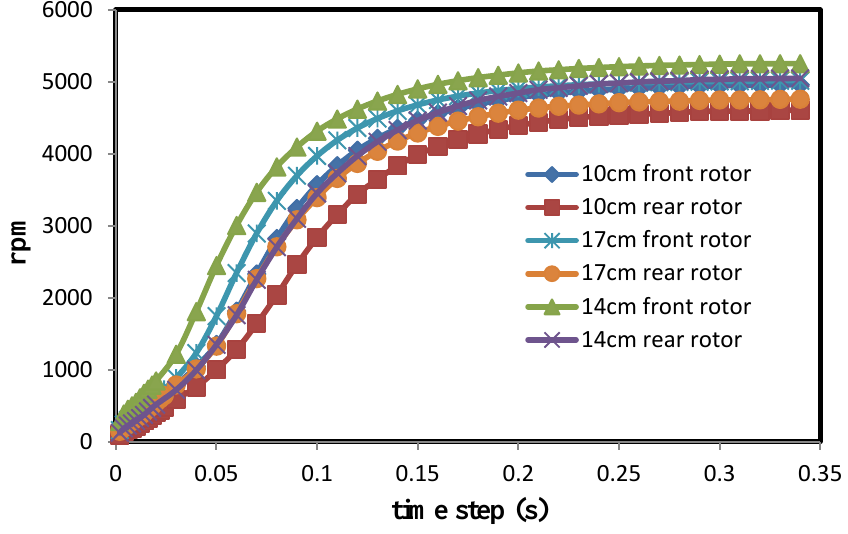
Figure 10. Relationships between rpm and time step.